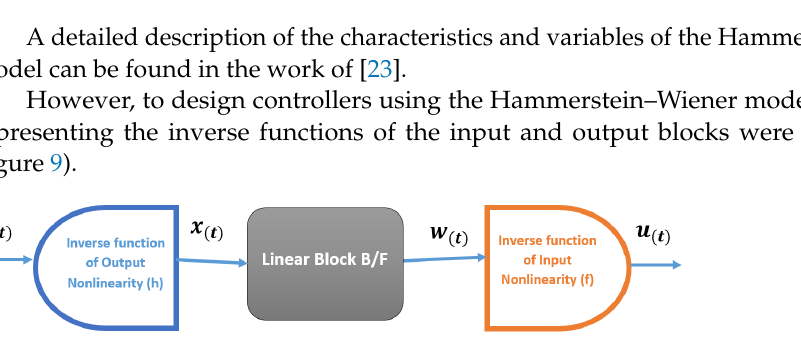
Figure 8. Block diagram of the Hammerstein–Wiener model.